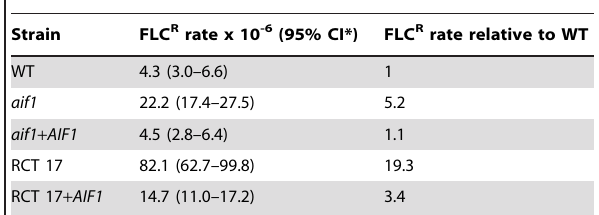
Figure 2. Disruption of apoptosis-inducing factor stimulates the selection of fluconazole resistant subpopulations. A . Etest strip assays showing that deletion of aif1 increases the frequency of the intrinsic adaptive fluconazole heteroresistant phenotype of serotype A wild-type strain H99. B . aCGH analysis of a fluconazole-resistant colony isolated from the H99 wild-type background (CPS51) on an Etest assay showing a higher MIC (32 m g/ml) but no alteration in chromosome numbers. C . aCGH analysis of a FLC R clone CPS106, isolated from the CPS51 background on Etest assay showing complete resistance to FLC (MIC . 256 m g/ml) and Chr1 disomy. D-E . Clones isolated from the aif1 mutant immediately show complete resistance to FLC (MIC . 256 m g/ml) and multiple whole or partial chromosome duplications. Clone CPS18 is disomic for Chr1 ( D ) and clone CPS24 has segmental duplications of chromosomes 1 and 3 ( E ). Vertical bars in red indicate amplifications, and in green deletions, that are statistically significant. Vertical bars in gray indicate no DNA copy number alteration or amplifications or deletions that did not meet the statistical settings.